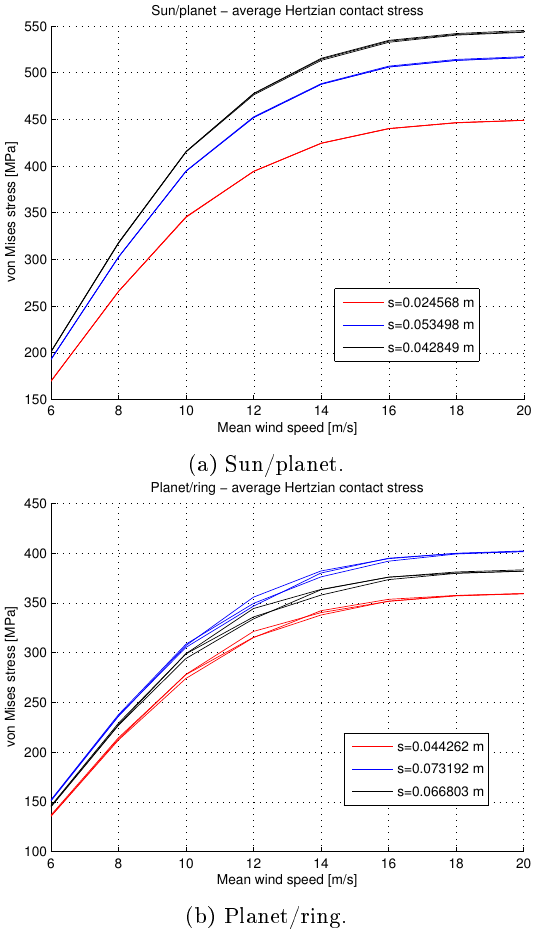
Figure 13: Average von Mises contact stress for